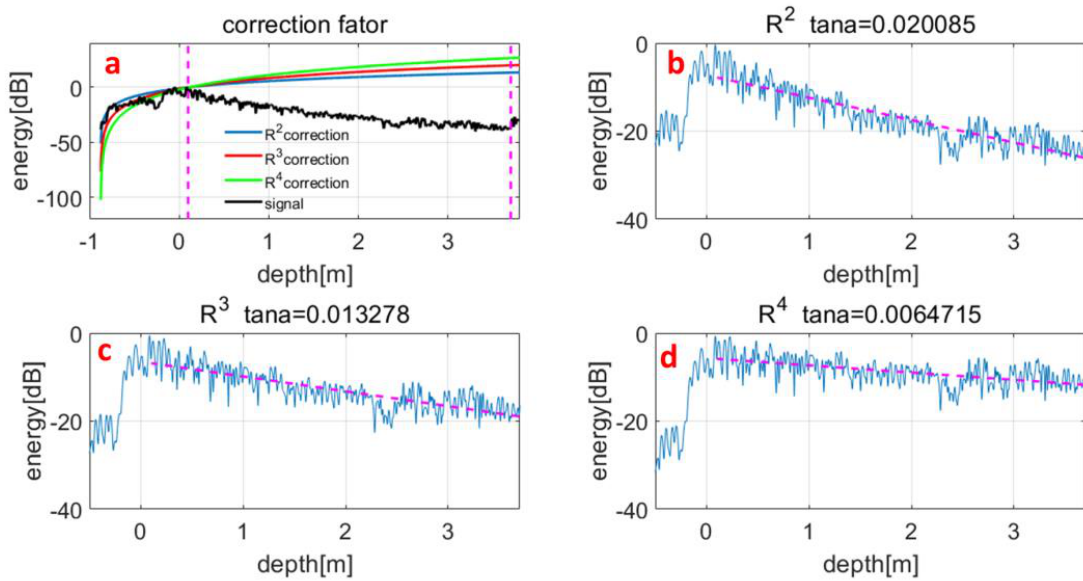
Figure 11. Lunar regolith attenuation characteristics derived from LRPR. The relative dielectric constant 2.520 is utilized for time–depth conversion. R denotes the depth. Tana is the loss tangent. ( a ) The interval of pink dotted line is the interval selected to evaluate the attenuation characteristics of the lunar regolith. ( b – d ) The pink lines are the linear fitting results of the power attenuation with depth, and the attenuation coefficient of the lunar regolith can be derived from the slope of the fitting line.